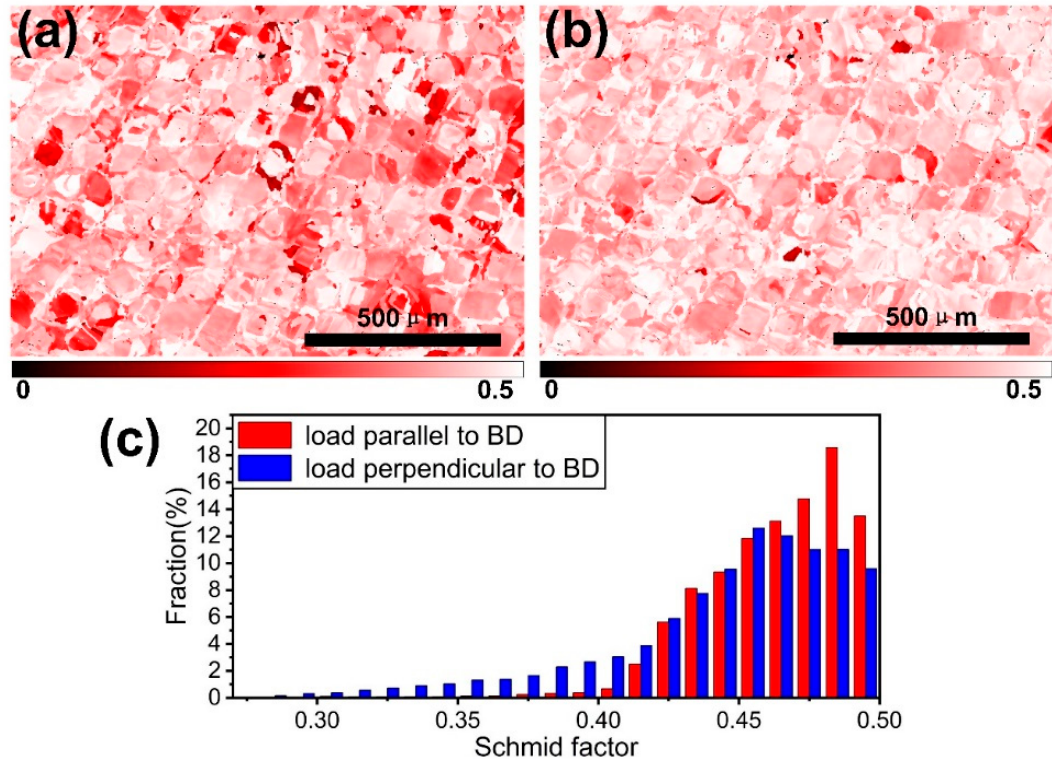
Figure 8. Schmid factor maps for ( a ) loading perpendicular to BD, ( b ) loading parallel to BD and ( c ) corresponding Schmid factor distribution map in ( a , b ).